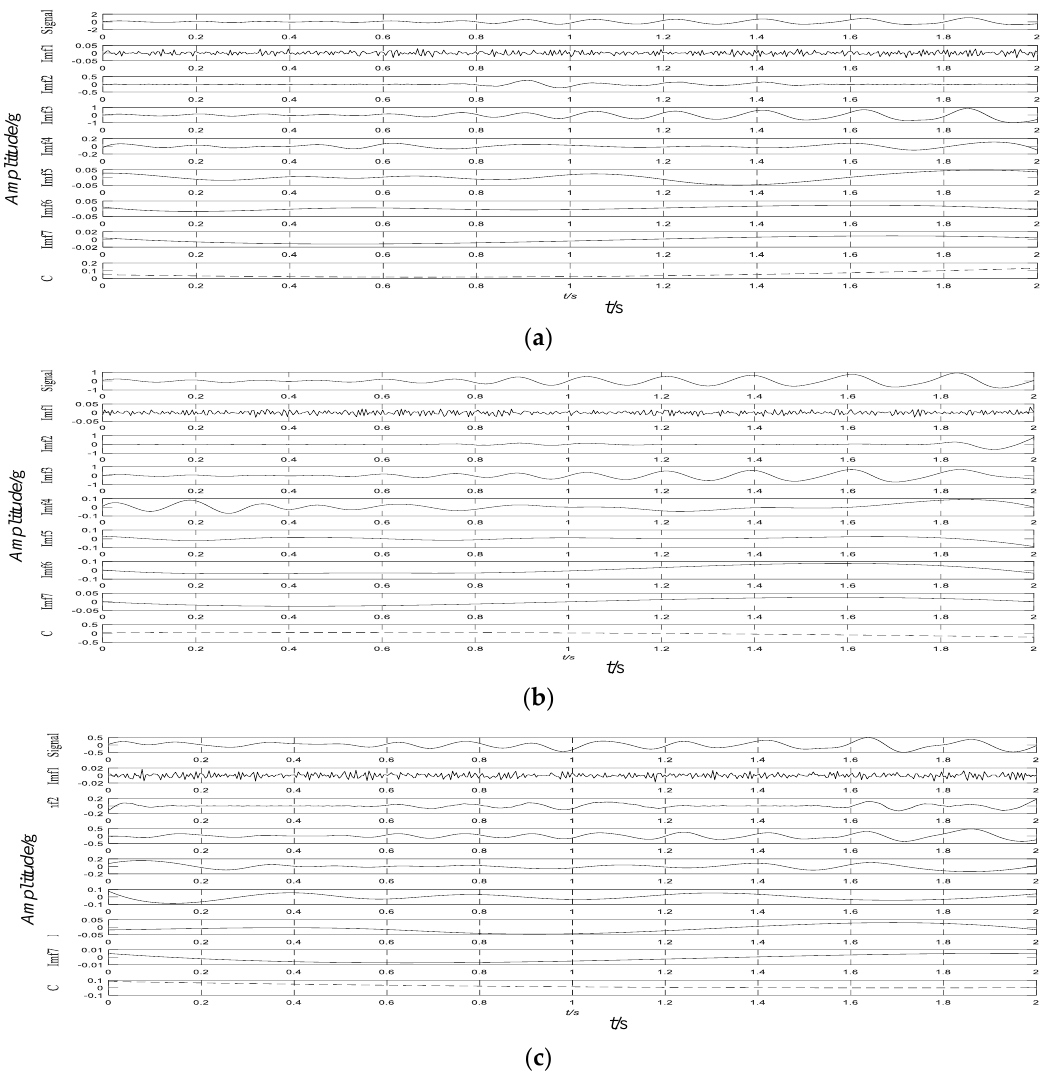
Figure 7. Ensemble Empirical Mode Decomposition (EEMD) diagram of signals at different positions. ( a ) S1 position (bogie frame); ( b ) S2 position (bogie frame); ( c ) S3 position (axle box).